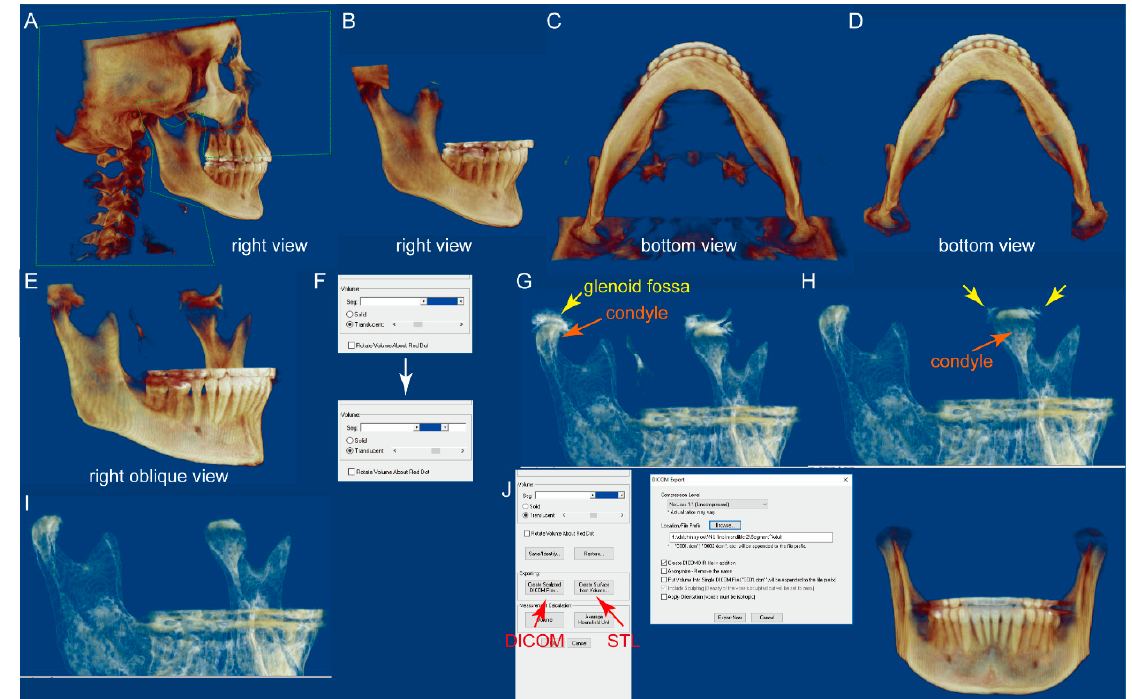
Figure 1. The flowchart of the mandible segmentation protocol by using the Dolphin 3D sculpting tool. ( A , B ) On the right view, sculpt the majority of the cranial structure and maxilla with the “free form” tool. ( C , D ) On the bottom view, the border of the condyles can clearly be seen. ( E – G ) On the right oblique view, enlarge the cone-beam computed tomography (CBCT) and change the “Seg Volumes,” which will produce a translucent view of the right condyle (orange arrow), glenoid fossa (yellow arrow), and remaining maxillary structures. ( H ) After sculpting around the left condyle in the left oblique view, return to the right oblique view. Some remaining cranial structures can be found around the left condyle (yellow arrows). Sculpt them ( I ). ( J ) The segmented mandible CBCT can either be exported as DICOM files or be used to create the surface structure and saved as an STL file.